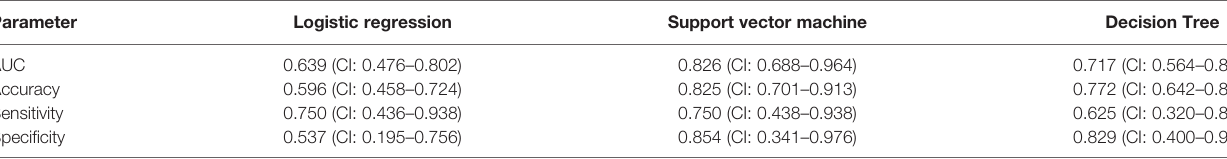
TABLE 4 | ROC curve analysis of three models in the testing set.